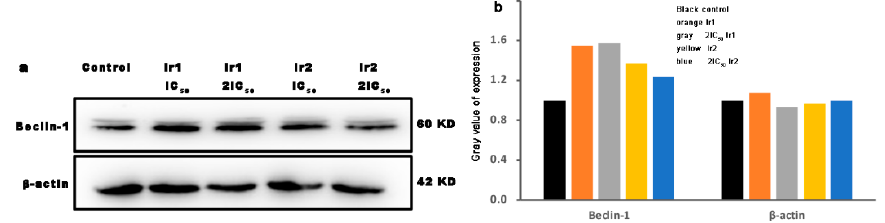
Figure 12. ( a ) Autophagy assay of HCT116 cells exposed to IC 50 and 2IC 50 concentration of Ir1 and Ir2 for 24 h. ( b ) The gray values of the expression of Beclin-1, β -actin was used as internal control.